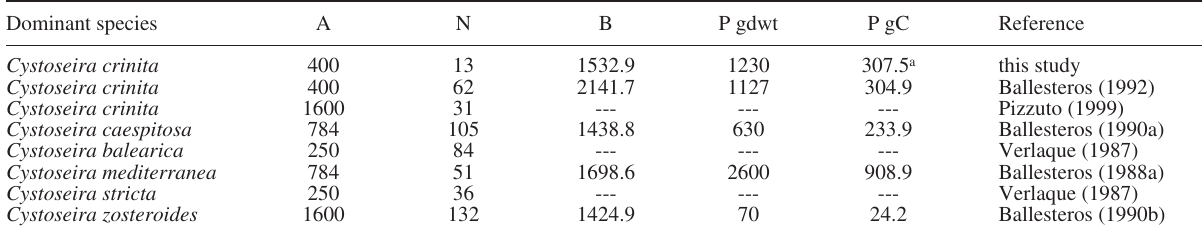
Table 5. – Structural parameters of different Cystoseira -dominated assemblages from the northwestern Mediterranean (A: sampling area in cm 2 ; N: number of species per sample; B: biomass in g dwt m –2 ; P gdwt: annual production of the dominant species in g dwt m –2 y –1 ; P g C: annual production of the dominant species in g C m –2 y –1 ). Dominant species